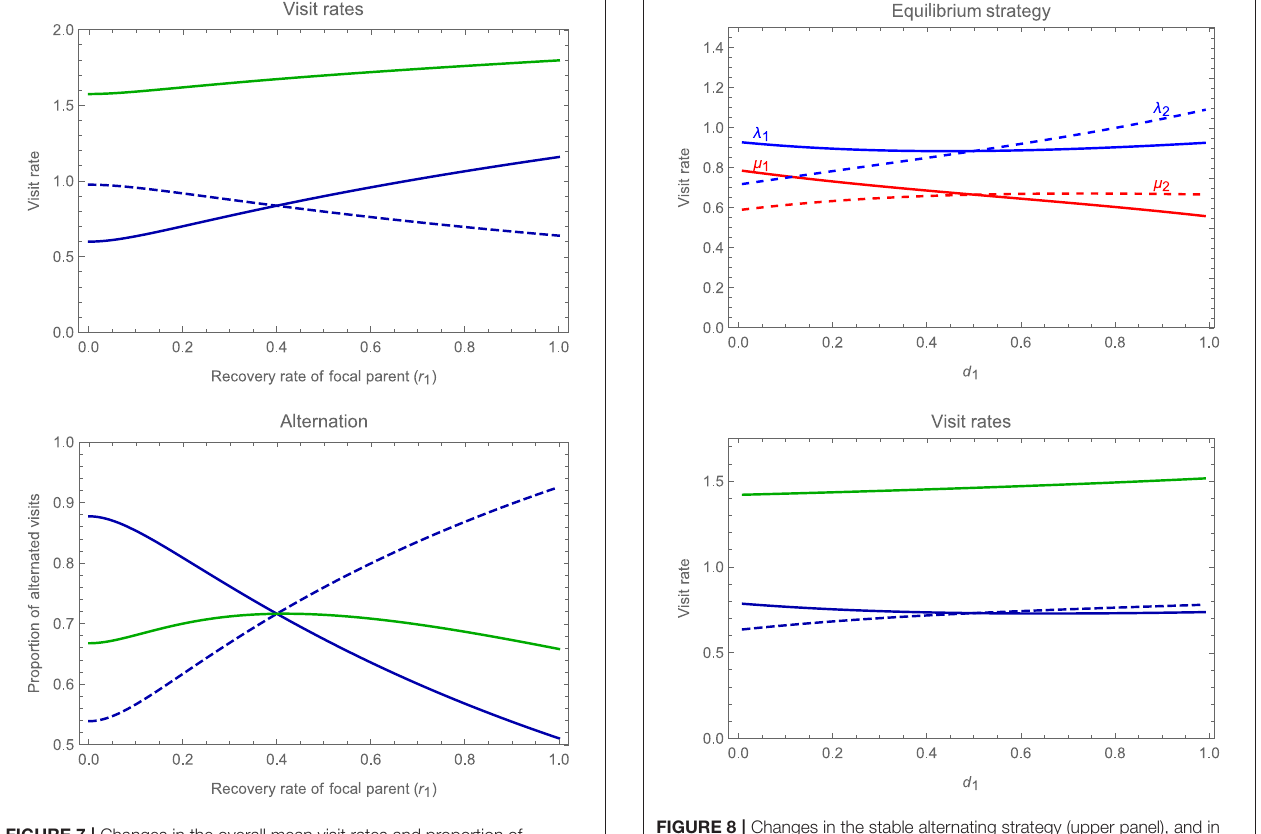
FIGURE 7 | Changes in the overall mean visit rates and proportion of alternated visits by both parents, as one varies a focal parent’s recovery rate independently of its partner’s recovery rate (i.e., allowing for asymmetries between the parents). The upper panel shows the overall mean visit rate of the focal parent (solid blue curve) and of its partner (dashed blue curve), as well as the total mean visit rate (green curve), as a function of the focal parent’s recovery rate r 1 (while holding the partner’s recovery rate r 2 constant at a value of 0.4). The lower panel shows the proportion of alternated visits by the focal parent (solid blue curve) and by its partner (dashed blue curve), as well as the total proportion of alternated visits by both parents (green curve), again as a function of the focal parent’s recovery rate r 1 . Other parameter values and payoffs are as specified in the legend to Figure 6 .